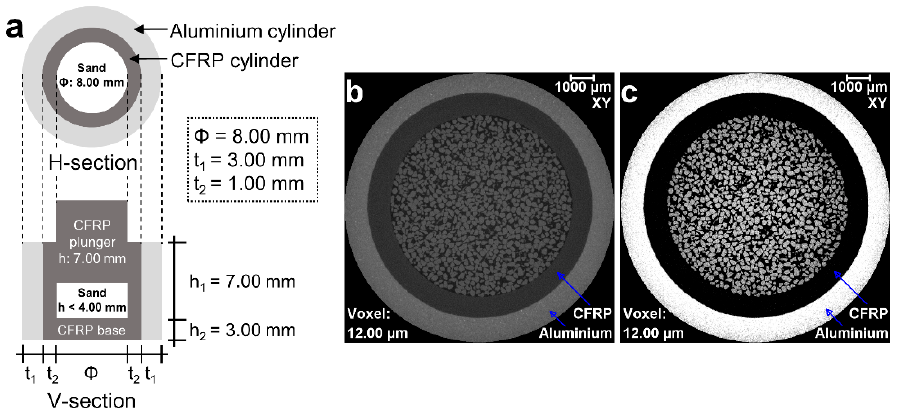
Figure 1. ( a ) Plan view and elevation of the new carbon fibre reinforced polymer (CFRP) compression cell encapsulated in an aluminium cylinder with plunger and base support; ( b ) an orthoslice of the reconstructed sand volume (intensity range: 0 to 65,535); and ( c ) an orthoslice showing the ease of particle segmentation due to inclusion of the CFRP (intensity range: 14,500 to 24,700).